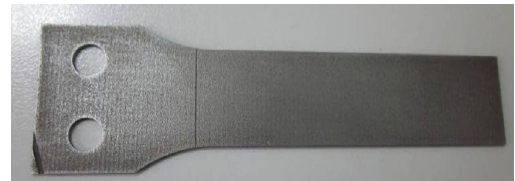
Fig. 2 Blade morphology.